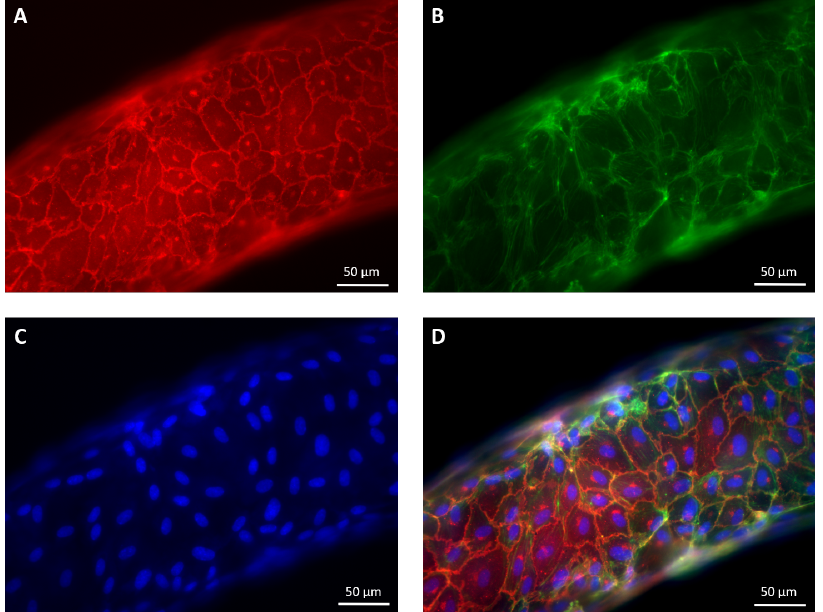
Figure 4. Examples of confocal fluorescence tiles captured for the same portion of the vascular channel with different colour channels. ( A ) VE-cadherin. ( B ) Actin. ( C ) Cell nuclei. ( D ) Merging of the fluorescence